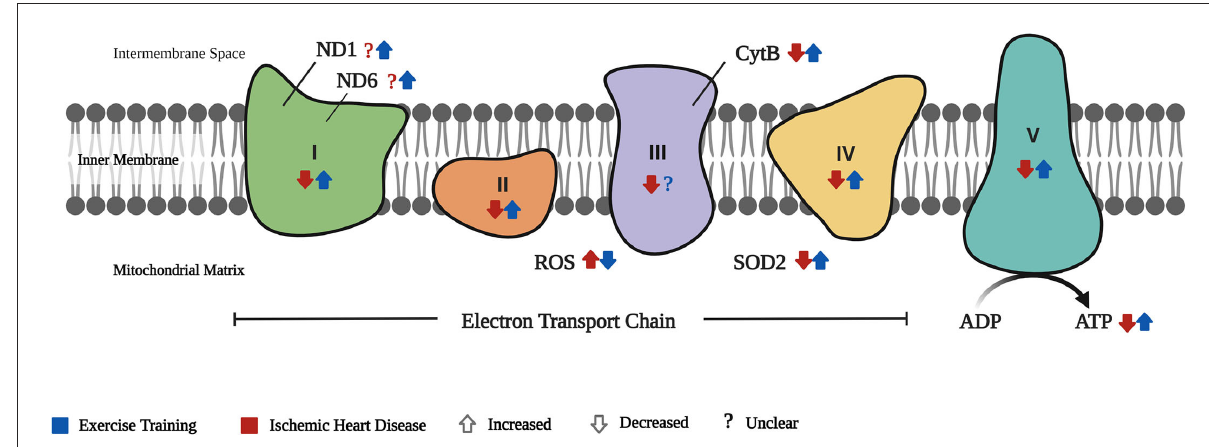
FIGURE2 Cardiac mitochondrial respiration. The effect of IHD and exercise training (ET) on the cardiac mitochondrial respiration is depicted by the different components involved in the electron transport chain (ETC). ND1 and ND6 are components of the complex 1 of the ETC wherein there is no clear evidence of its effect in IHD, while ET increased the expression of these biomarkers. Complexes I–V are involved in the passage of electrons (with IHD–decreased; ET–increased complexes I, II, IV, and V, but no clear evidence on ET’s effect in complex III). With IHD, ROS in the ETC is increased but is reversed by ET. Conversely, SOD2 is decreased in IHD and ET increases its expression. The end product of ETC, the ATP, is decreased in IHD, whereas ET improved its